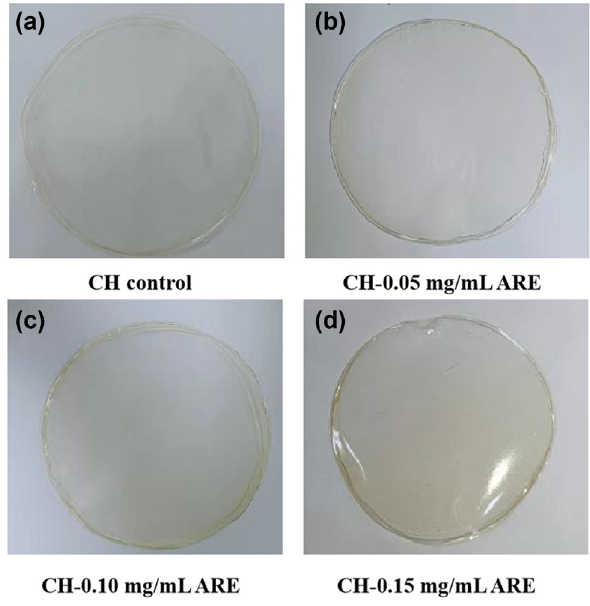
Figure 1: The digital photo of CH/ARE composite fi lms: ( a ) CH con - trol, ( b ) CH - 0.05 mg · mL − 1 ARE, ( c ) CH - 0.10 mg · mL − 1 ARE, and ( d ) CH - 0.15 mg · mL − 1